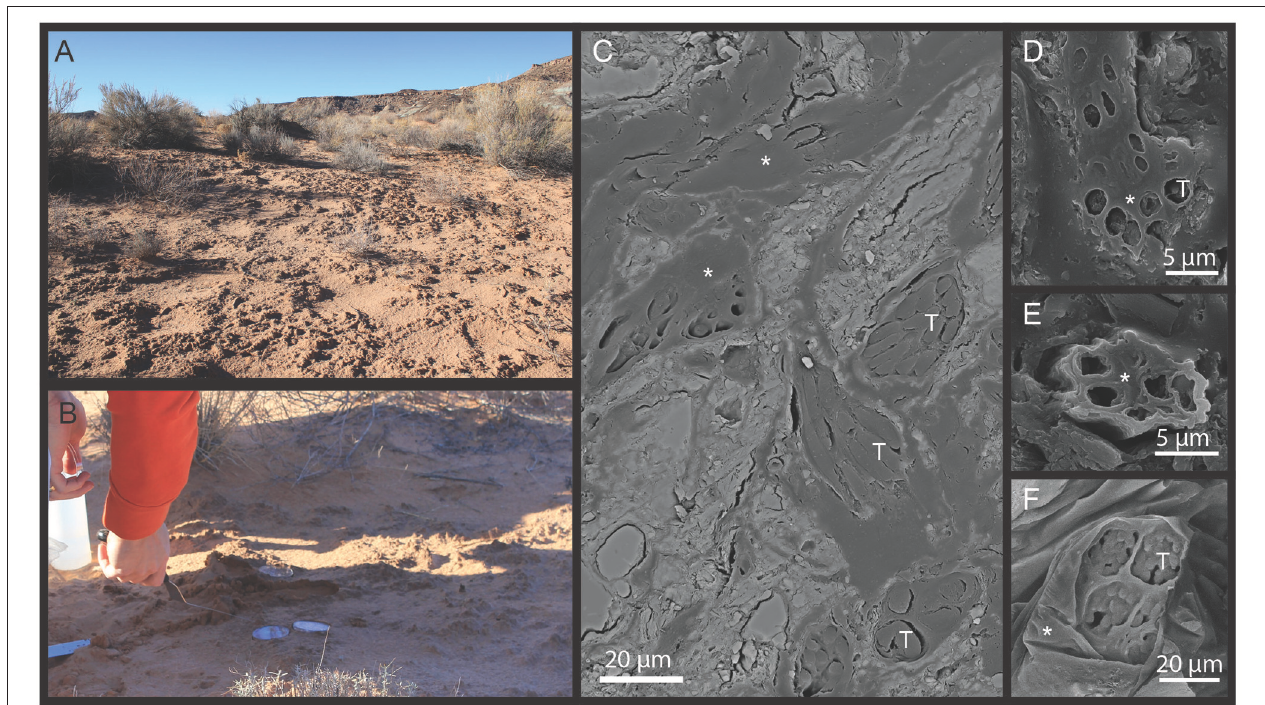
FIGURE 1 | (A) Aspect of the field site and (B) sampling illustration. (C–F) SEM pictures of a biocrust polished section using backscattered electron (C) and secondary electron (D,E) showing Microcoleus bundle (*) sheath material and cyanobacterial (T) trichomes in situ